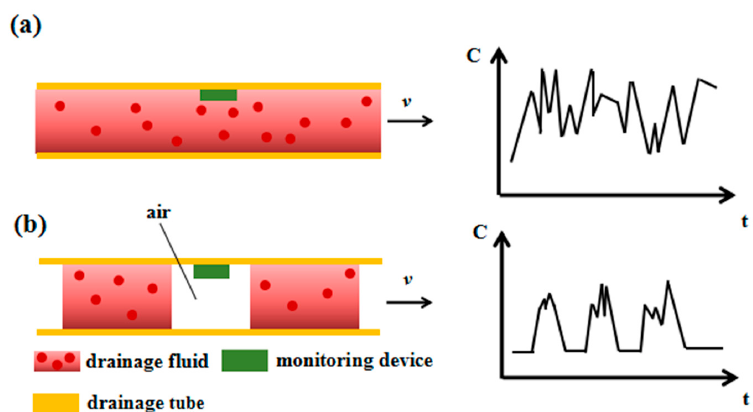
Figure 2. Schematic diagram of the flow state and the output of the sensor when the drainage tube is unblocked. ( a ) The working state of the drainage tube and the corresponding capacitance change curve when the entire drainage pipeline is unblocked and the liquid is continuously discharged. ( b ) The working state diagram of the drainage tube and the corresponding capacitance change curve of the sensor in the conditions of the entire pipeline is unobstructed and the amount of drainage liquid is small, where the liquid and air are intermittently discharged.